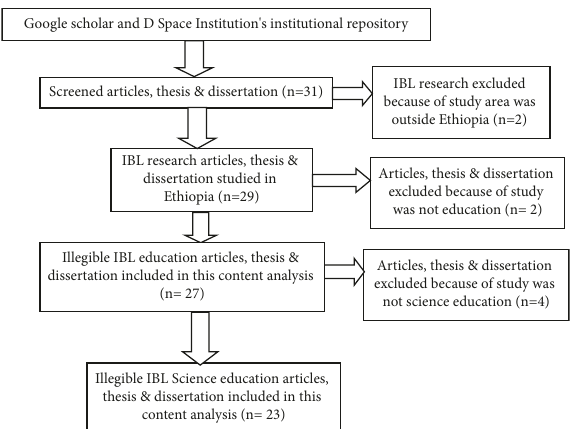
Figure 1: Flowchart of articles, theses, and dissertations selected for content analysis in